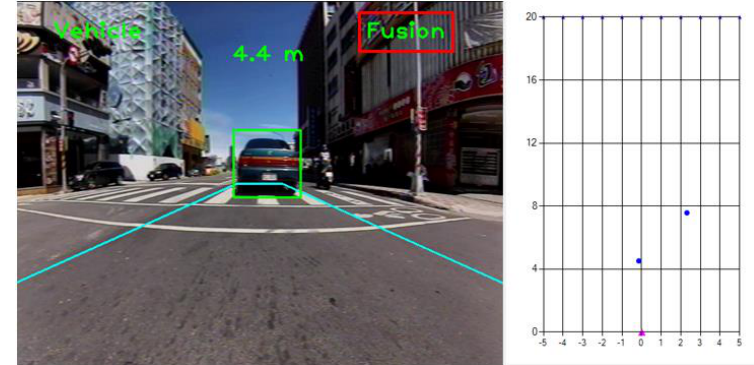
Figure 22. Detection result of sensor fusion system.